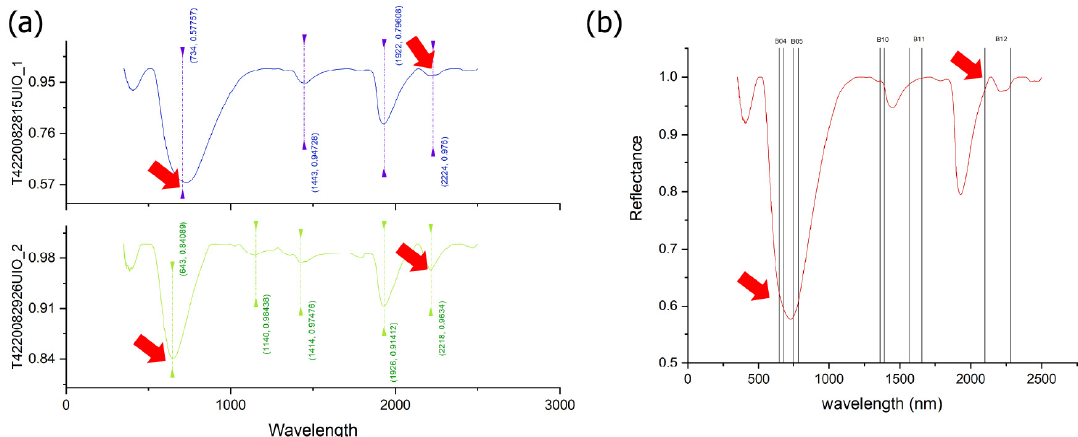
Figure 5. Spectra of amazonite samples from Tysfjord. ( a ) It is possible to see—indicated by red arrows—the main absorptions of the spectra collected in the laboratory. ( b ) Comparison of the absorption and reflectance features—indicated by red arrows—with the spectral range of the Sentinel 2 satellite bands.